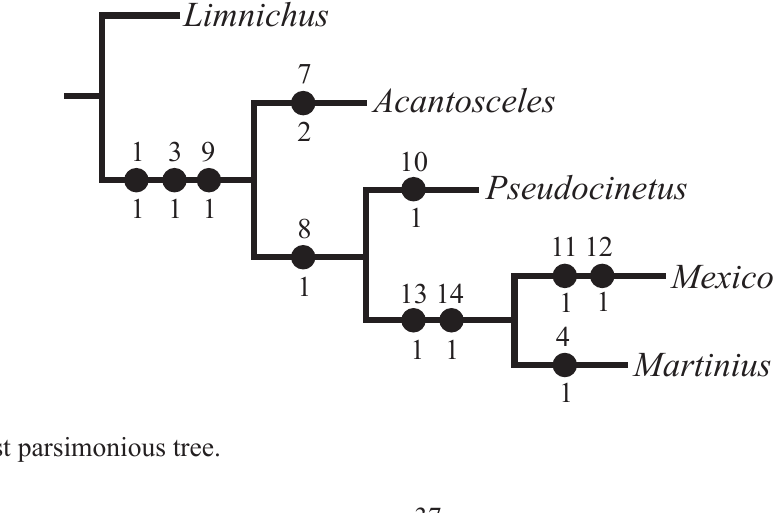
Fig. 20. Most parsimonious